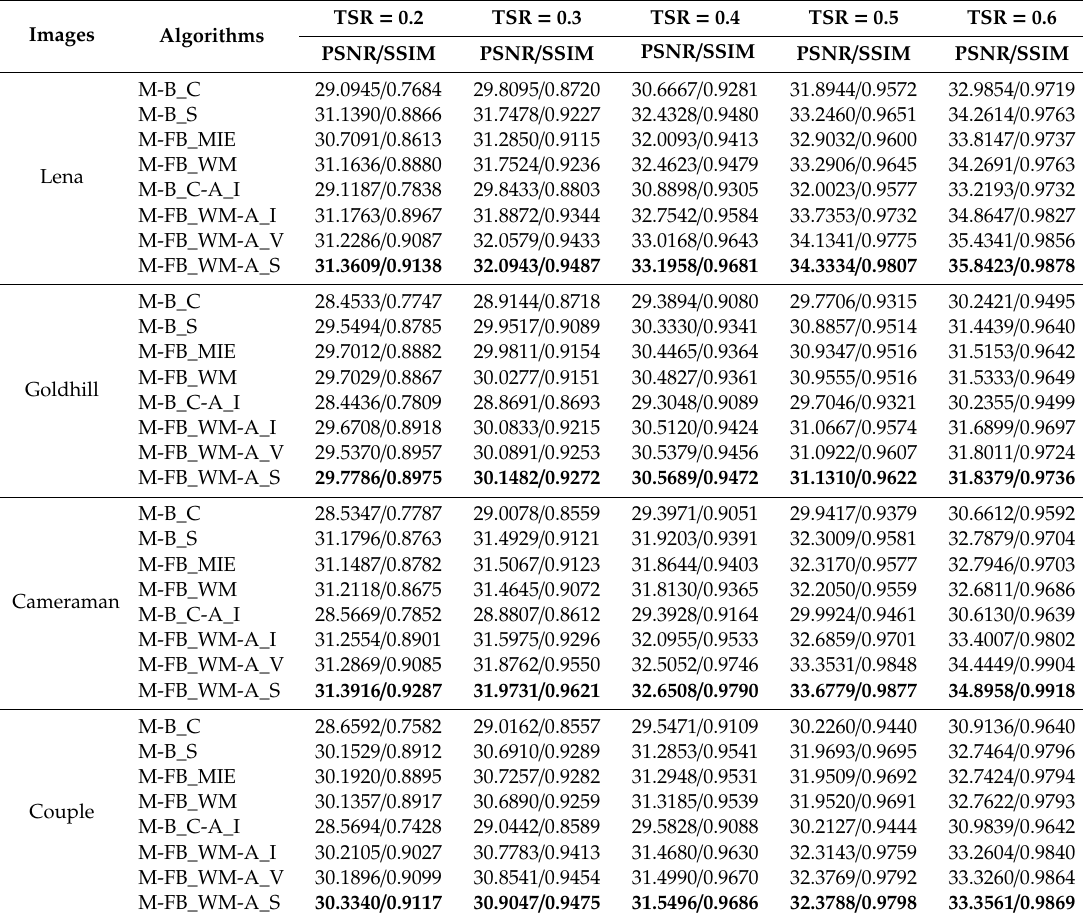
Table 1. The Peak Signal to Noise Ratio (PSNR) and Structural Similarity (SSIM) of reconstructed images with eight BCS algorithms based on OMP. (TSR = total sampling